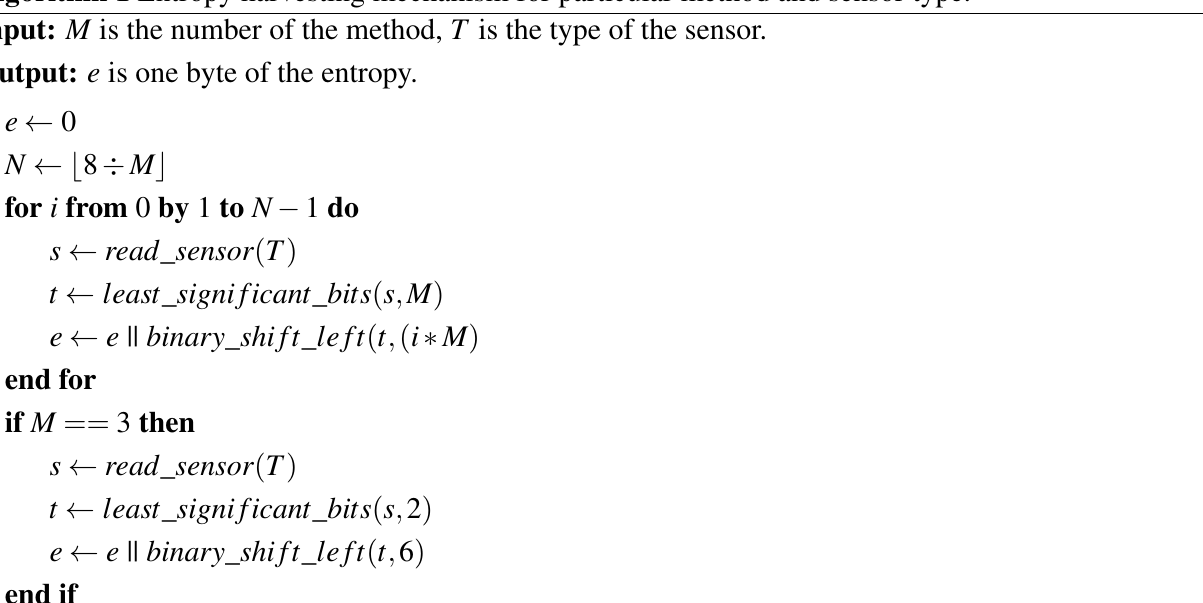
Algorithm 1 Entropy harvesting mechanism for particular method and sensor